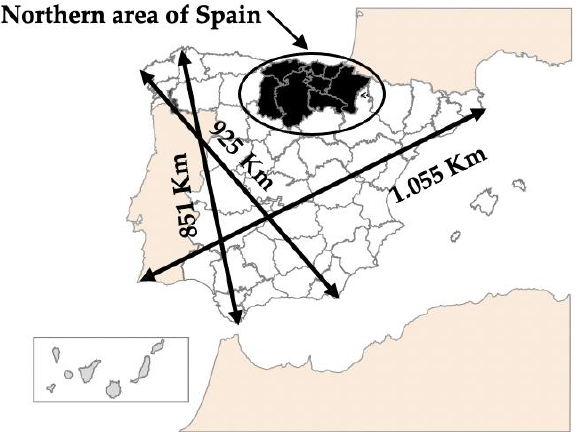
Figure 1. Northern area of Spain: Cantabria, Biscay, Gipuzkoa, Alava, La Rioja, Navarre, Burgos, and Palencia (shaded in black). Table 1. Target sample of the study. Grandparents of children in primary education (6–12 years) in northern